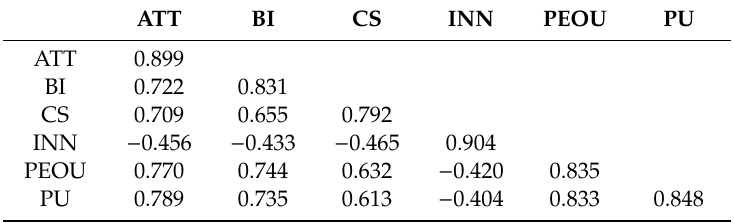
Table 8. Discriminant validity.